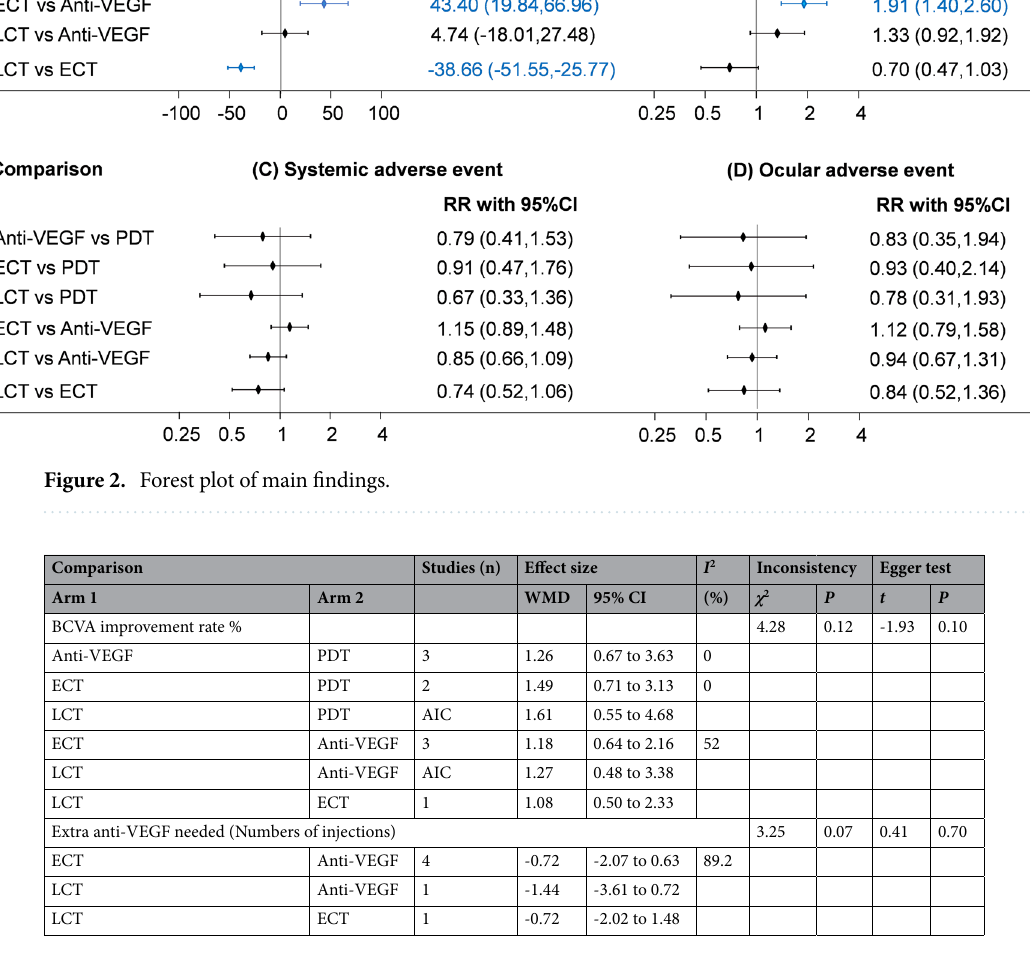
Table 3. Summary of outcomes. AIC, adjusted indirect comparison; Anti-VEGF, anti-vascular endothelial growth factor; BCVA, best-corrected visual acuity; CI, confidence interval; ECT, early combination therapy; LCT, late combination therapy; PDT, photodynamic therapy; WMD, weighted mean